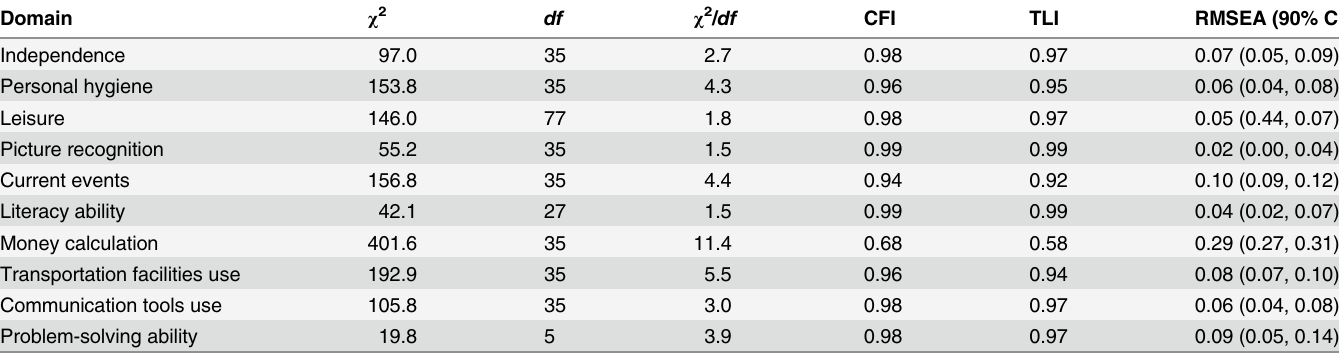
Table 2. Fit indices of the 10 domains of the ADLRS-III (n =